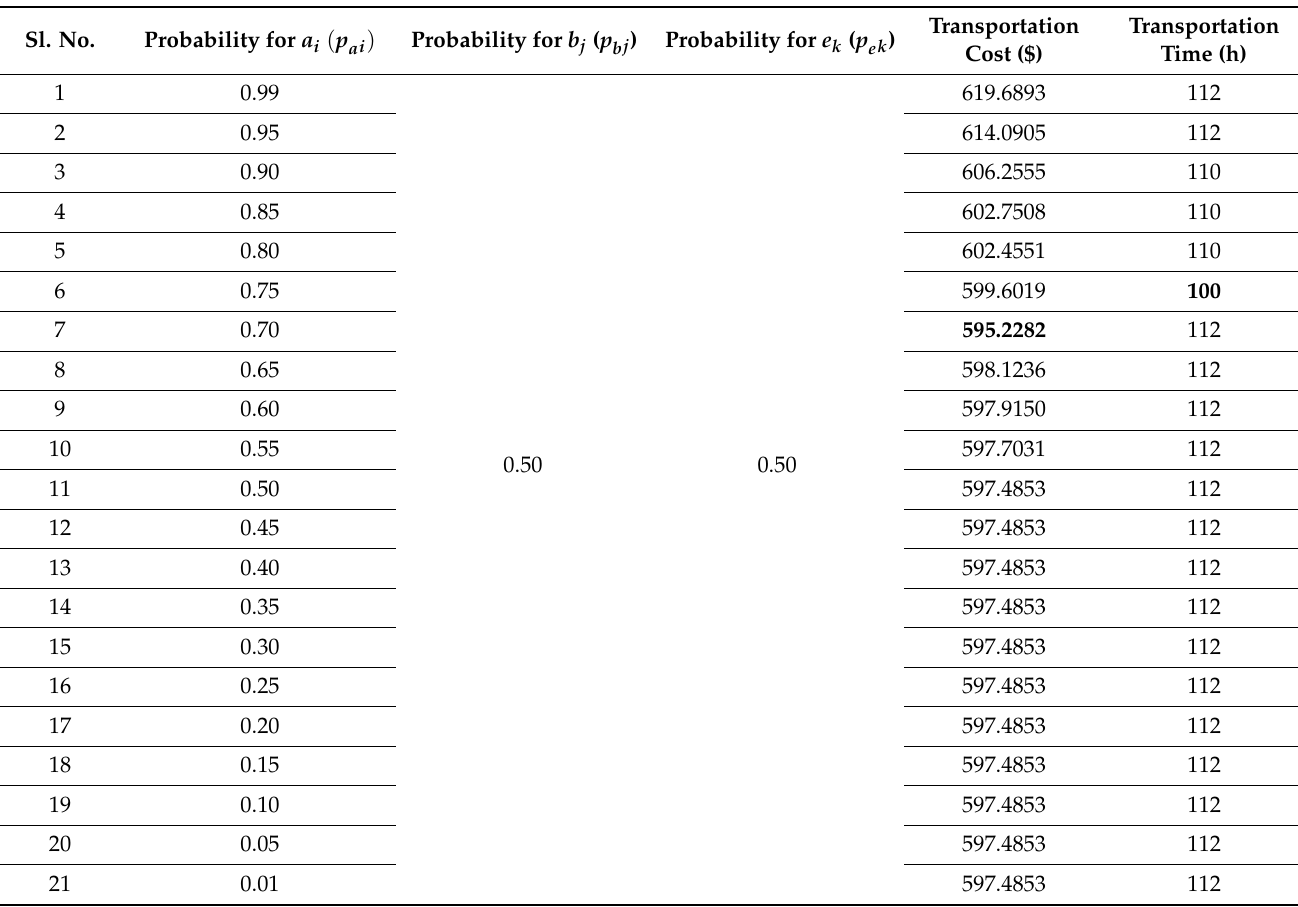
Table 7. Sensitivity analysis concerning the probability for a i